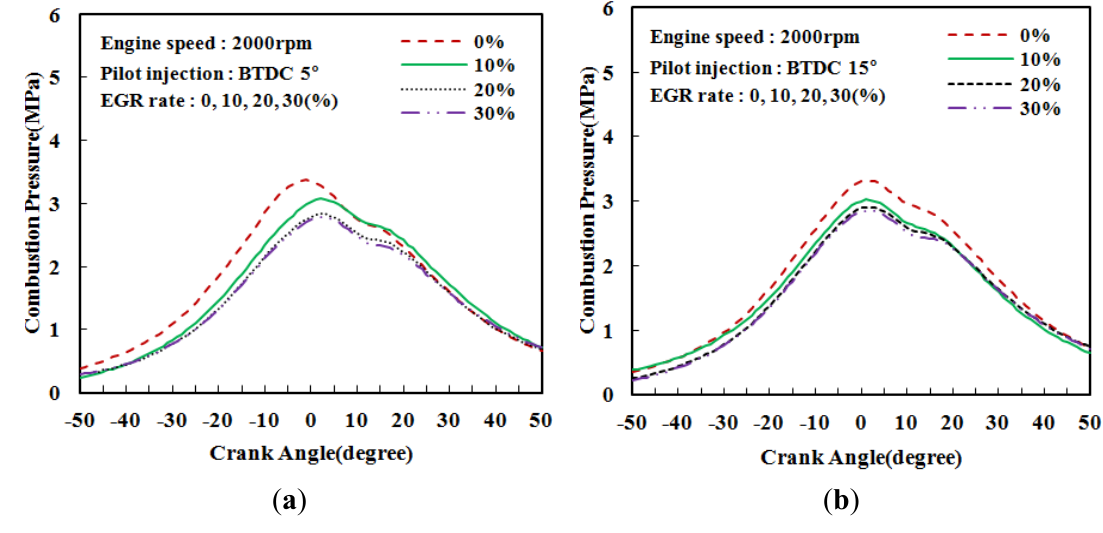
Figure 3. Comparison of combustion pressure at various pilot injection timings and EGR rates. ( a ) BTDC 5°; ( b ) BTDC